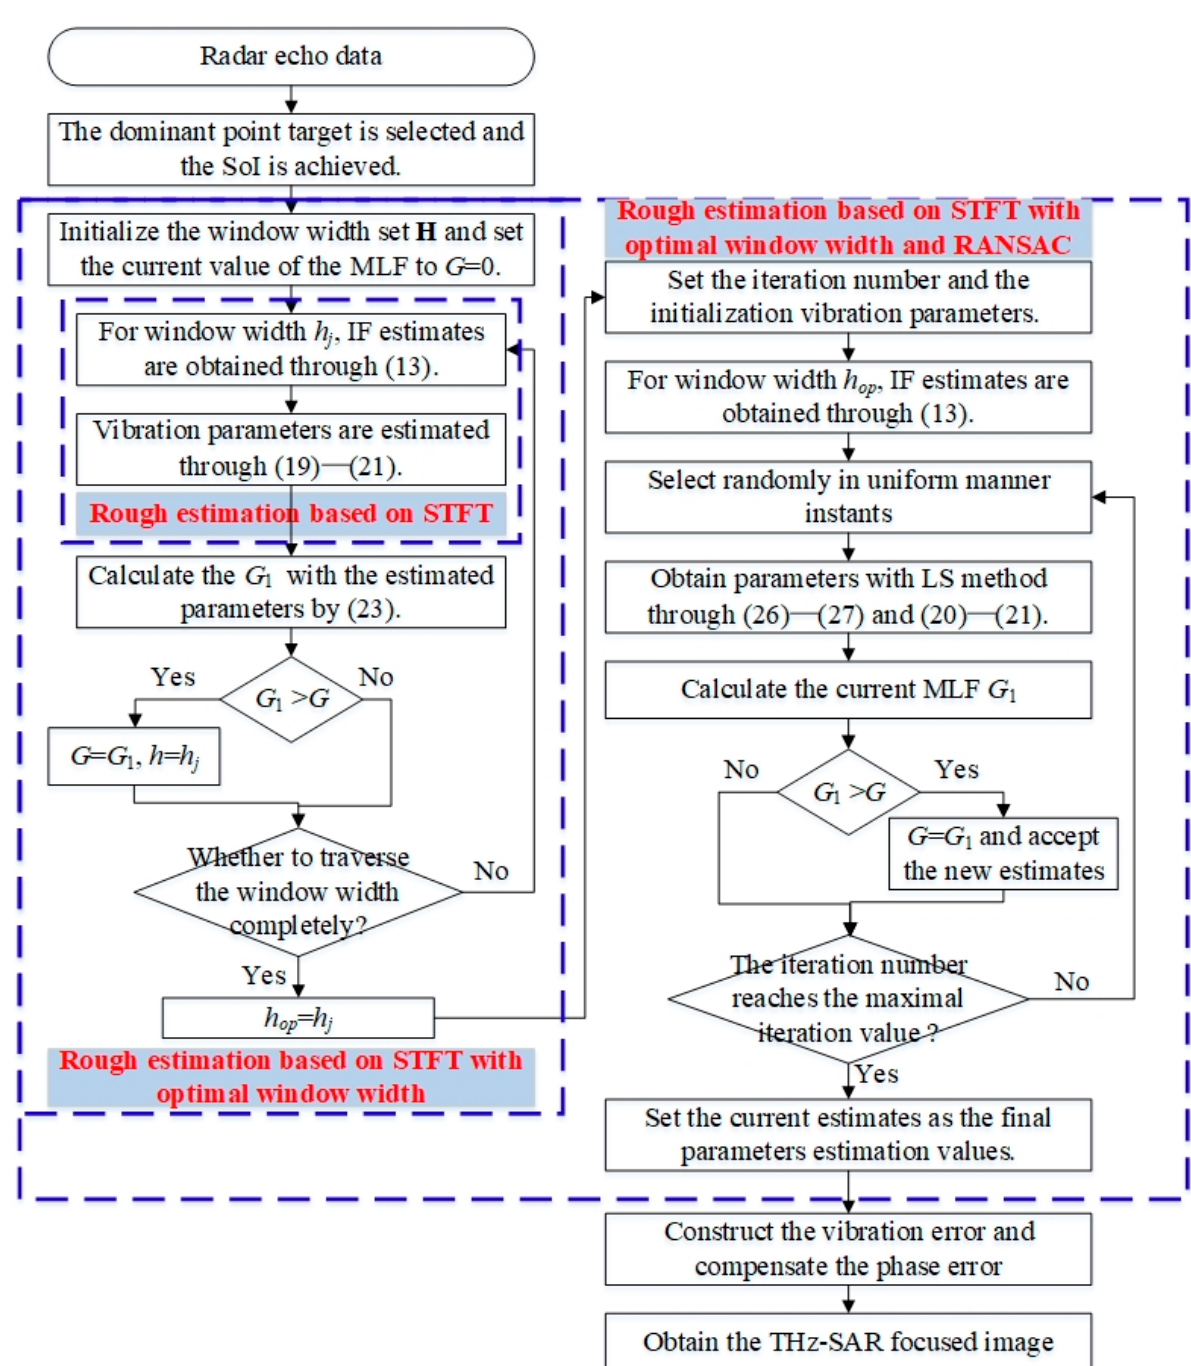
Figure 2. Flow chart of the proposed vibration error compensation estimate method.